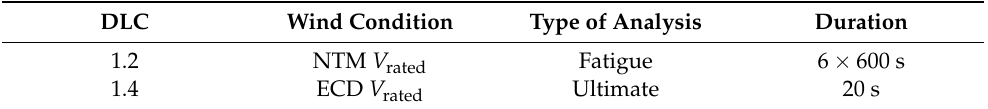
Table 2. Design load cases evaluated in this